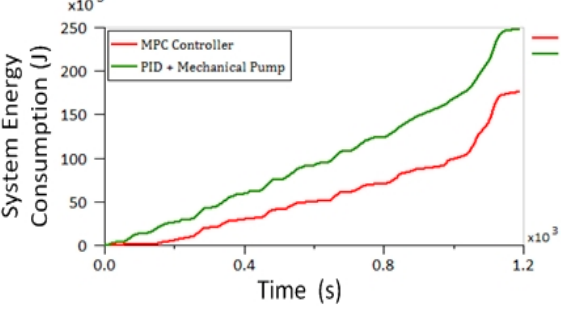
Figure 20. Comparison of the system energy consumption.